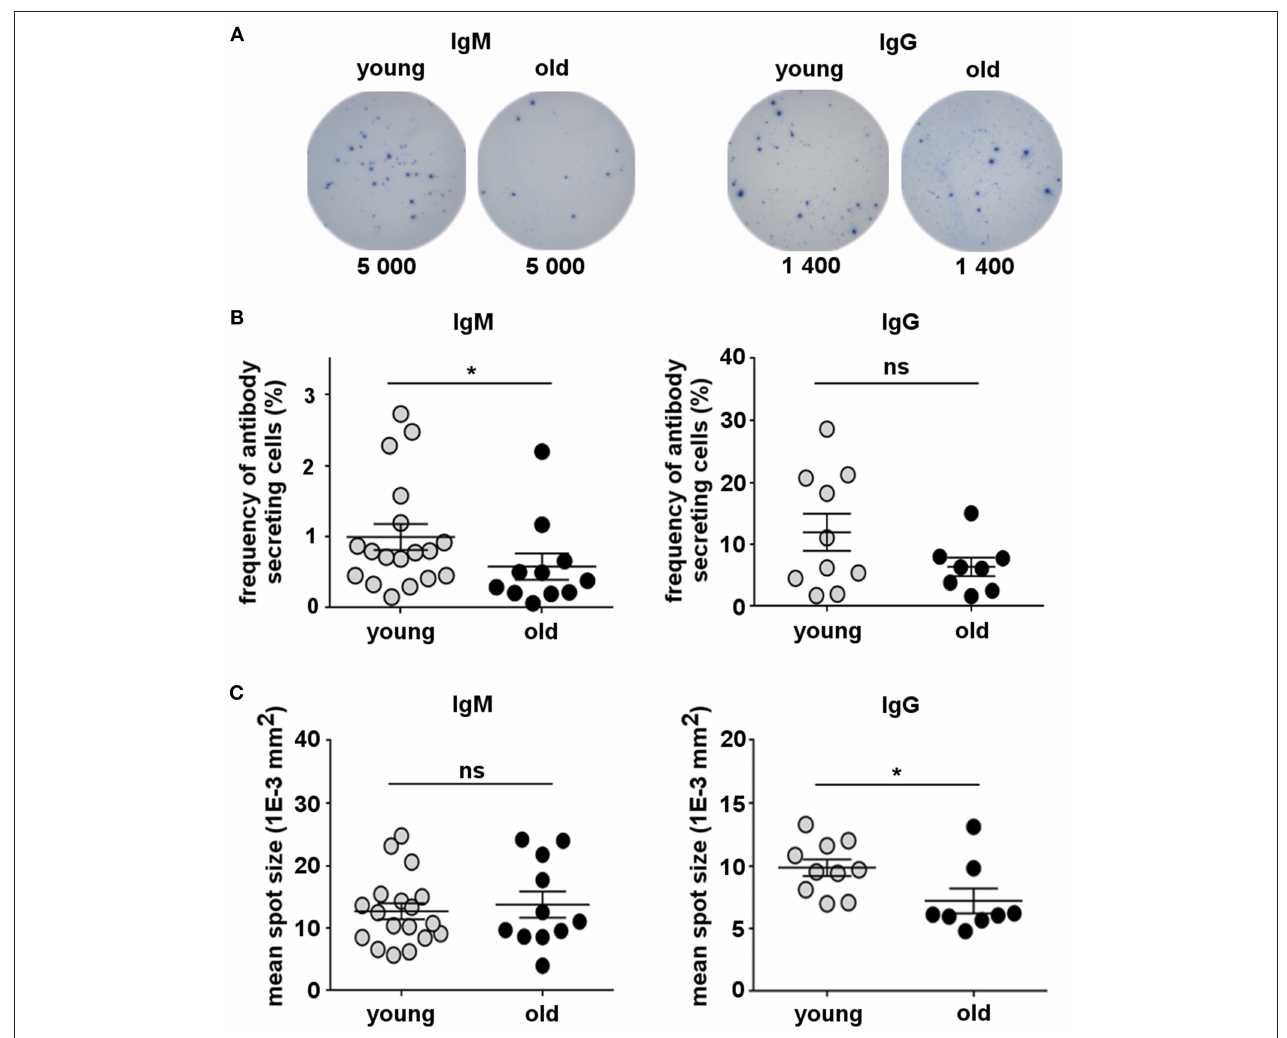
FIGURE 2 | Human B-1 cell spontaneous antibody secretion declines with advancing age. Sort-purified circulating B-1 cells were plated and analyzed for spontaneous IgM and IgG secretion by ELISPOT. (A) ELISPOT images corresponding to four different representative donors (2 young and 2 old) are shown. Each sample was tested in duplicate. The number of cells that were plated in each well is indicated. (B) Plots show the frequency of IgM- or IgG-secreting B-1 cells from young ( n = 10–18) and old ( n = 8–11) donors measured and analyzed by ImmunoSpot software. (C) Plots show the mean spot size of IgM- or IgG-secreted antibodies for each young ( n = 9–18) or old ( n = 8–10) donor. * p < 0.05 by Mann–Whitney U -test, bars are standard errors of the means